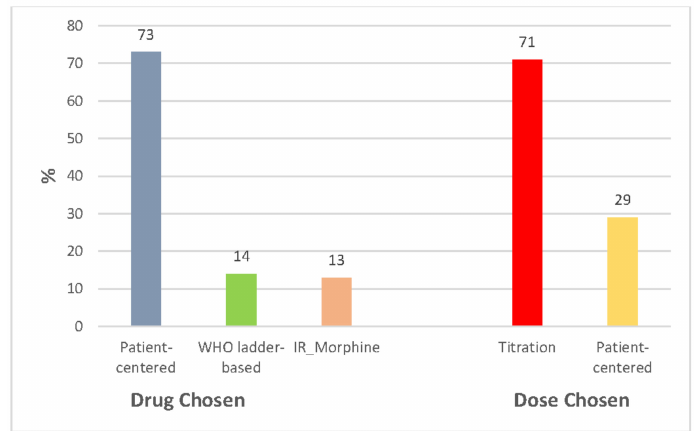
Figure 2. Opioid therapy in naïve patients. Abbreviation: IR,